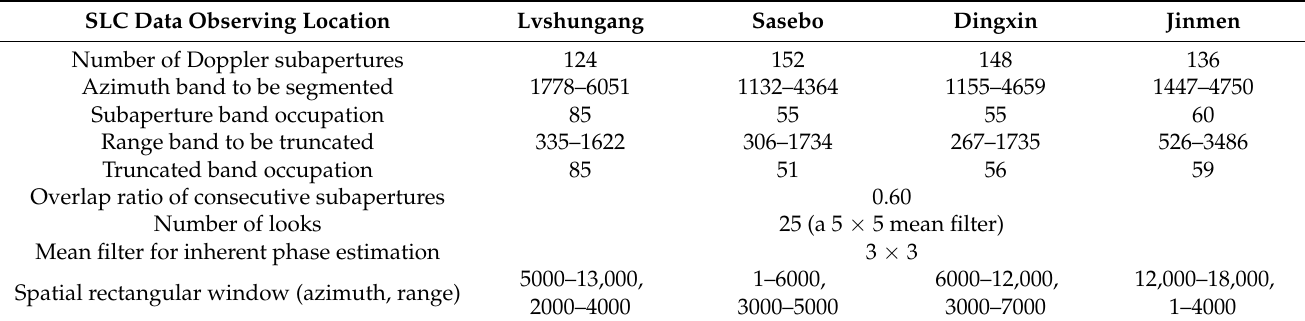
Figure 4. Frequency band segmentation used to achieve a low resolution. ( a ) Effective Doppler band in the azimuth direction and subaperture decompositions. ( b ) Corresponding chirp signal frequency bandwidth and truncated band. The results of Fourier transforms of Lvshungang image sequences are taken as examples. Table 2. Frequency allocation configurations and filter parameter